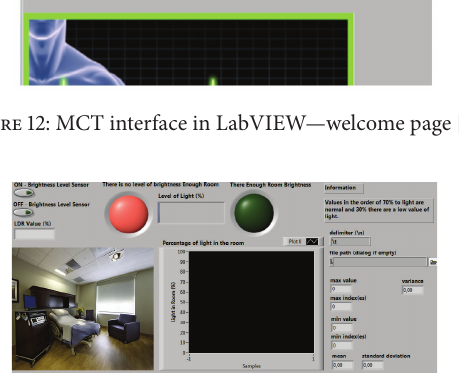
Figure 13: LabVIEW interface for environmental sensors—light sensor [14].